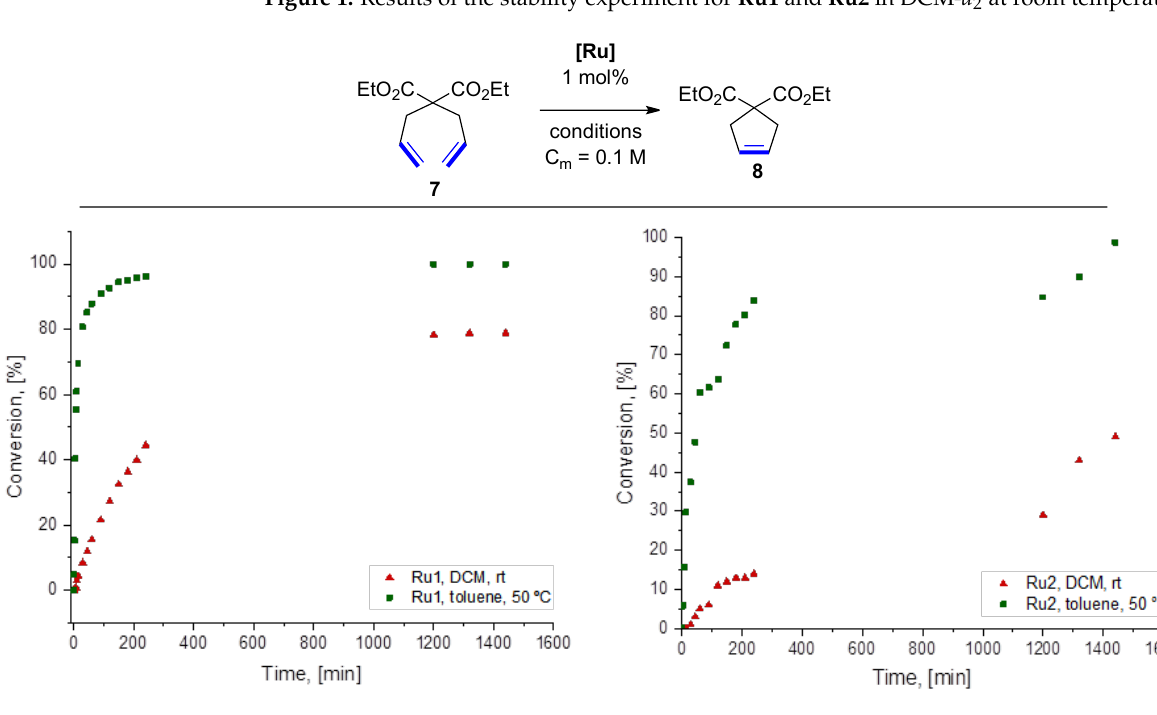
Figure 1. Results of the stability experiment for Ru1 and Ru2 in DCM- d 2 at room temperature.